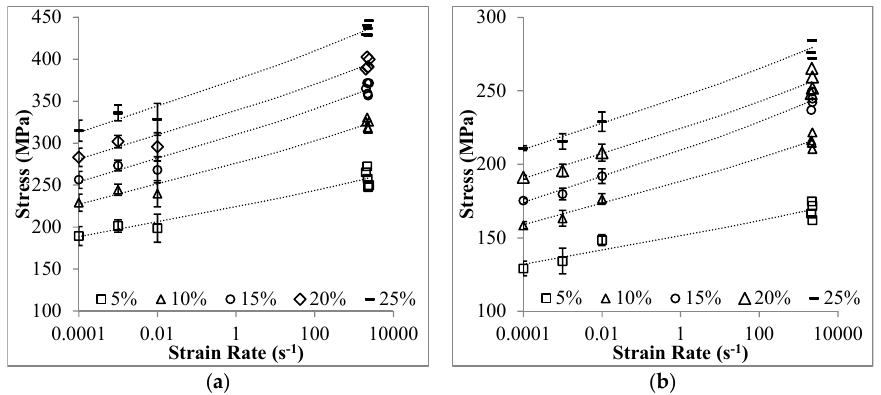
Figure 14. Stresses of ( a ) Invar ‐ 5CS; and ( b ) Invar ‐ 10CS at the strain from 5% to 25% plotted over strain rate.